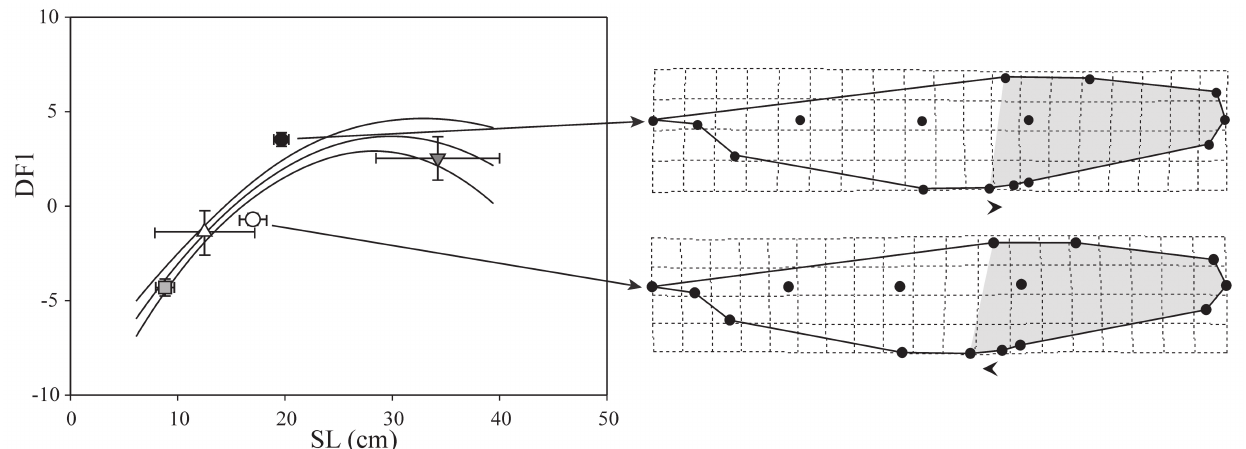
Fig. 7. Geometric Morphometric Analysis applied to Odontesthes bonariensis individuals. Left: plot of DF1 vs. Standard length (SL), showing quadratic fit with 95% confidence interval (N= 100) and means and 95% confidence intervals by sampling sites (locality labels as in Fig. 1) ULLM (gray square), CARZ (white circle), D (black square), URRE (white triangle), PELE (gray triangle). Right: Deformation grids correspond to a relative warps analysis (see Table 3) involving only CARZ and D. Arrows indicate displacement of landmarks relative to consensus. Shaded area remarks relative position of landmarks 5 (anterior insertion of the first dorsal fin) and 12 (distal tip of the pelvic fin onto fish